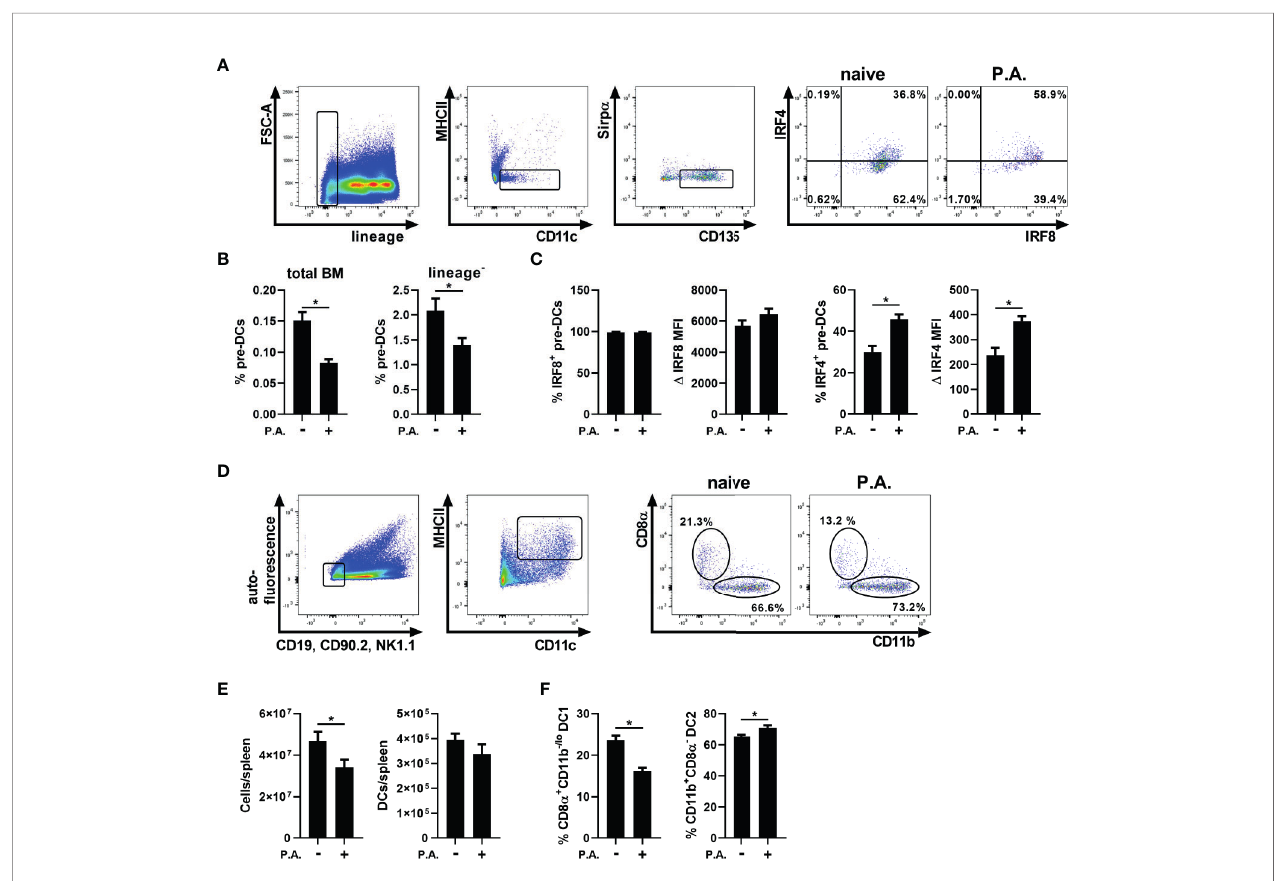
FIGURE 2 | Intranasal instillation with P. aeruginosa induced a systemic effect on bone marrow cDC precursors and spleen cDC populations. WT mice were euthanized 18 h following i.n. instillation of 5 x 10 5 CFU of P. aeruginosa (P.A.) and bone marrow and spleen cells were analyzed by fl ow cytometry. (A) Bone marrow pre-DCs sequential gating strategy (lineage - , MHC II - , CD11c + , Sirp a lo/- , CD135 + ) and representative fl ow cytometry pro fi le of IRF4 and IRF8 expression in pre-DCs from naive and P. aeruginosa treated mice. (B) Percentage of bone marrow pre-DCs in total bone marrow cells and lineage - cells. (C) Bone marrow pre- DCs: percentage and D MFI of IRF8 and IRF4. (D) Spleen cDCs sequential gating strategy (auto- fl uorescence - , CD19 - , CD90.2 - , NK1.1 - , MHC II Hi and CD11c + ) and representative fl ow cytometry pro fi le of CD8 a and CD11b expression on cDCs from naive and P. aeruginosa treated mice. (E) Total spleen cells and spleen cDC number. (F) Percentage of CD8 a + CD11b - cDC1 and CD11b + CD8 a - cDC2 from spleen total cDCs. Data are presented as mean ± SEM; n = 8-10 mice per group combined from two separate experiments except for panel (C) , IRF4; n = 5 representative of three separate experiments. *p < 0.05 using unpaired